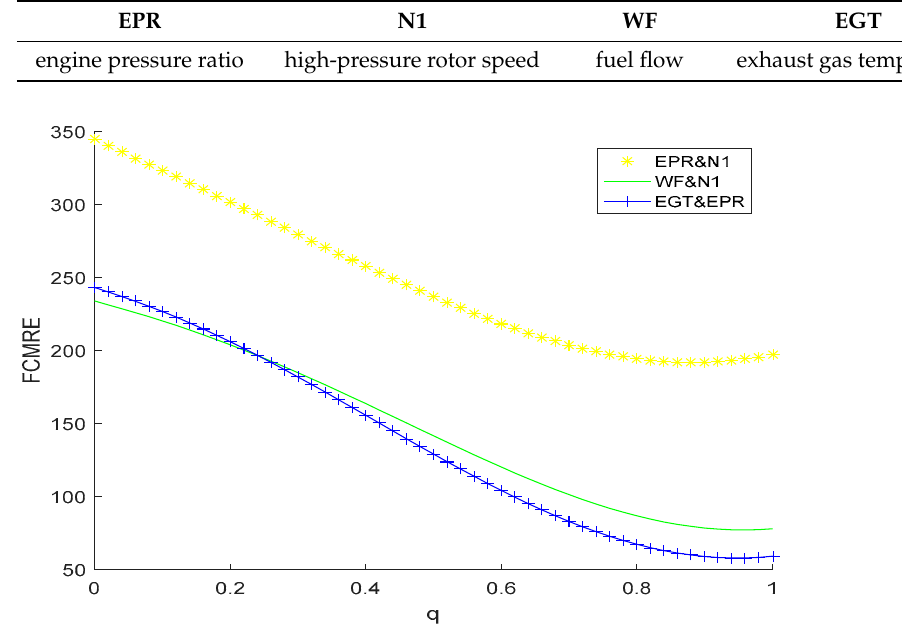
Figure 9. The fractional cumulative residual MRE of aeroengine gas path date N1, WF, EPR, and EGT time series.